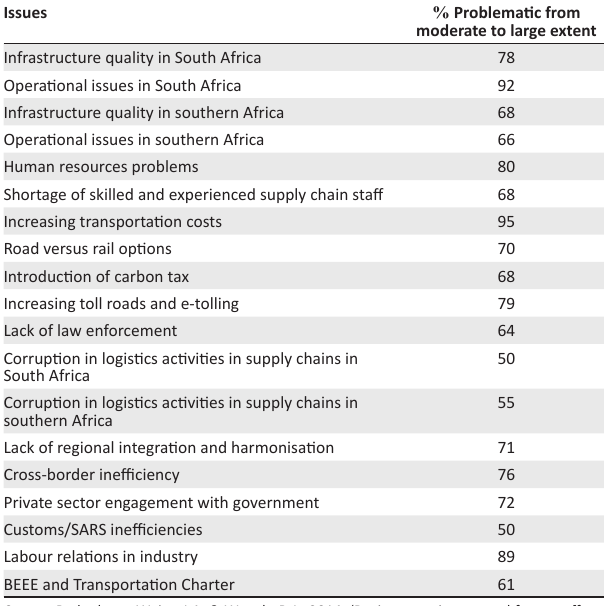
TABLE 1: Supply chain environmental risks of concern.